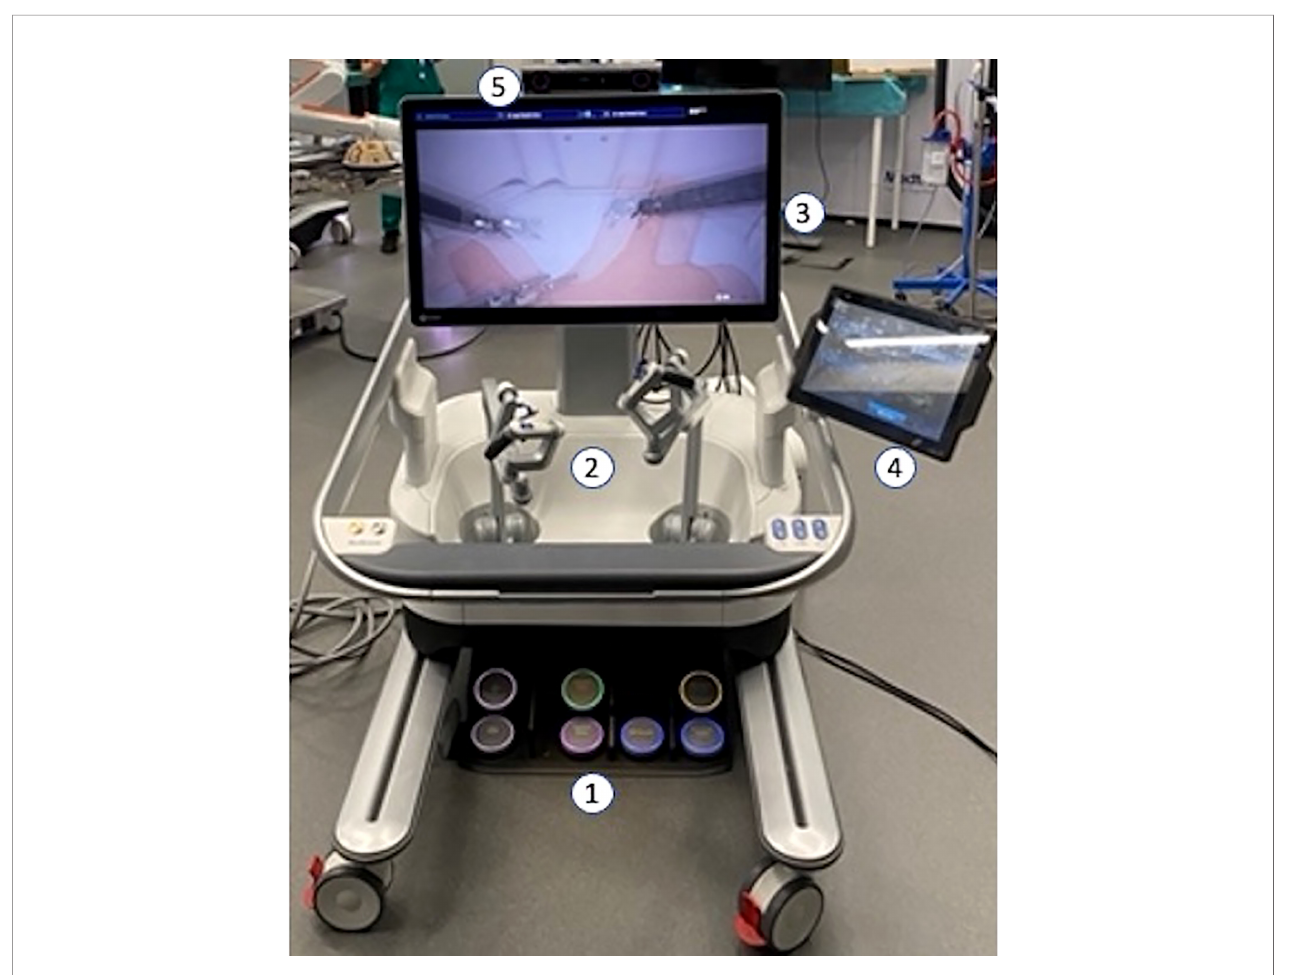
FIGURE 1 | 1 — Pedal unit; 2 — Pistol Grip Manipulators; 3 — 3D – HD monitor; 4 — Surgeon Interactive Display; 5 — Head Tracking